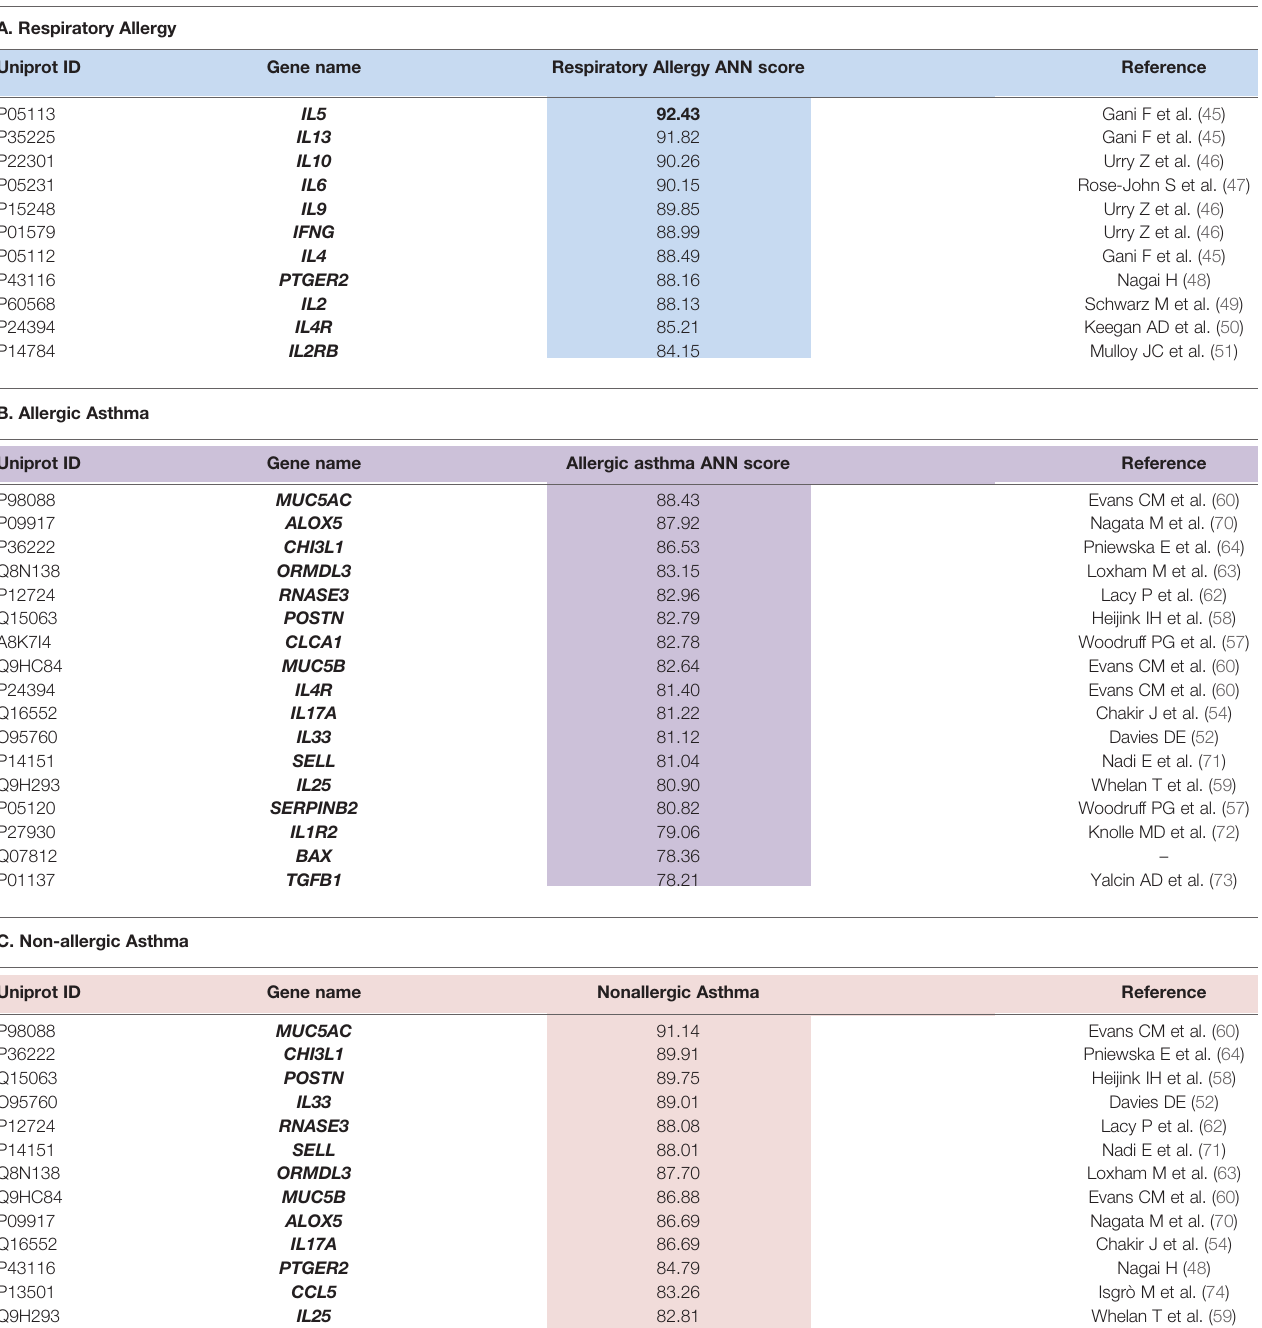
TABLE 2 | Summary of proteins presenting a “ HIGH ” or stronger relationship level with each